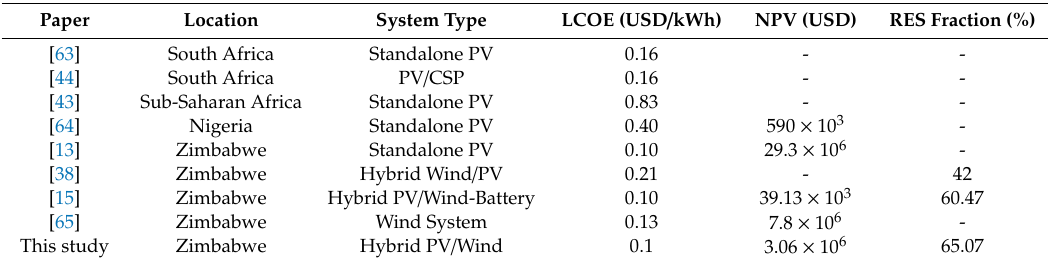
Table 3. Techno-economic comparison of di ff erent systems at similar geographic locations in Africa.